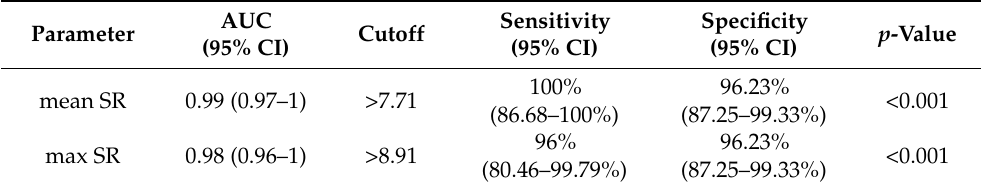
Table 5. Receiver operator characteristics (ROCs) analysis of mean and maximum SR values for distinguishing adenomy- osis from uterine fibroids.